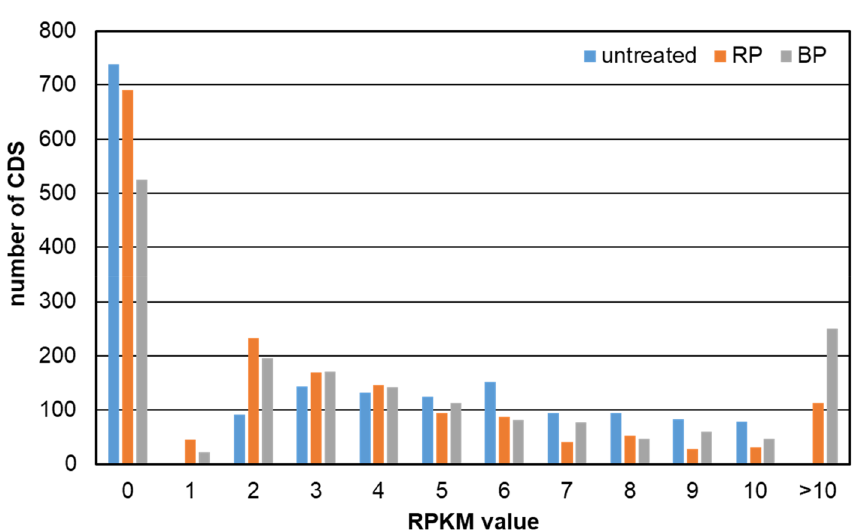
Figure 6. Distribution of 1731 CDS below RPKM 10 in the untreated sample compared to their RPKM distribution in the rRNA-depleted samples, either using RP or